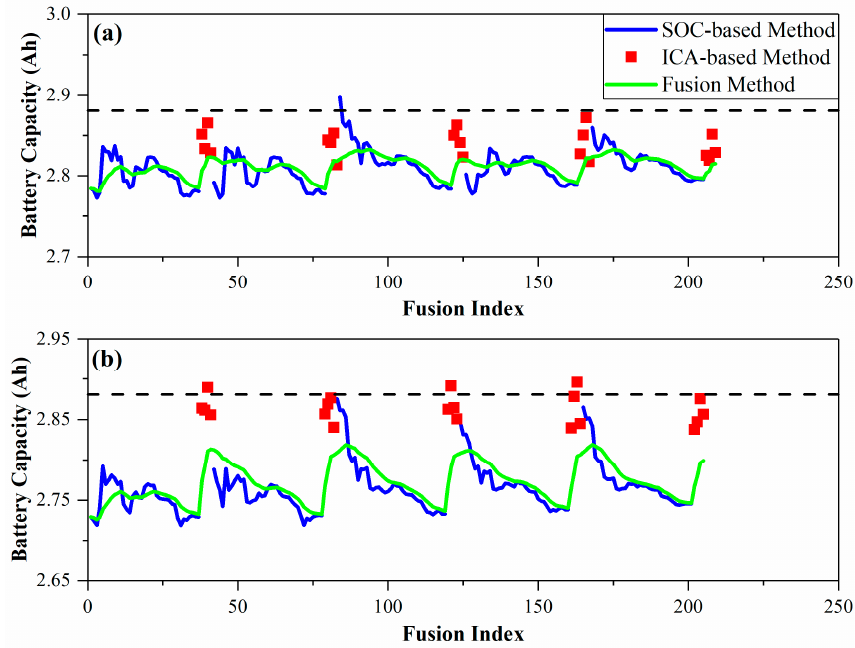
Figure 7. The estimation and fusion results of different fault scenarios. ( a , b ) are the results of Fault 1 and Fault 2.